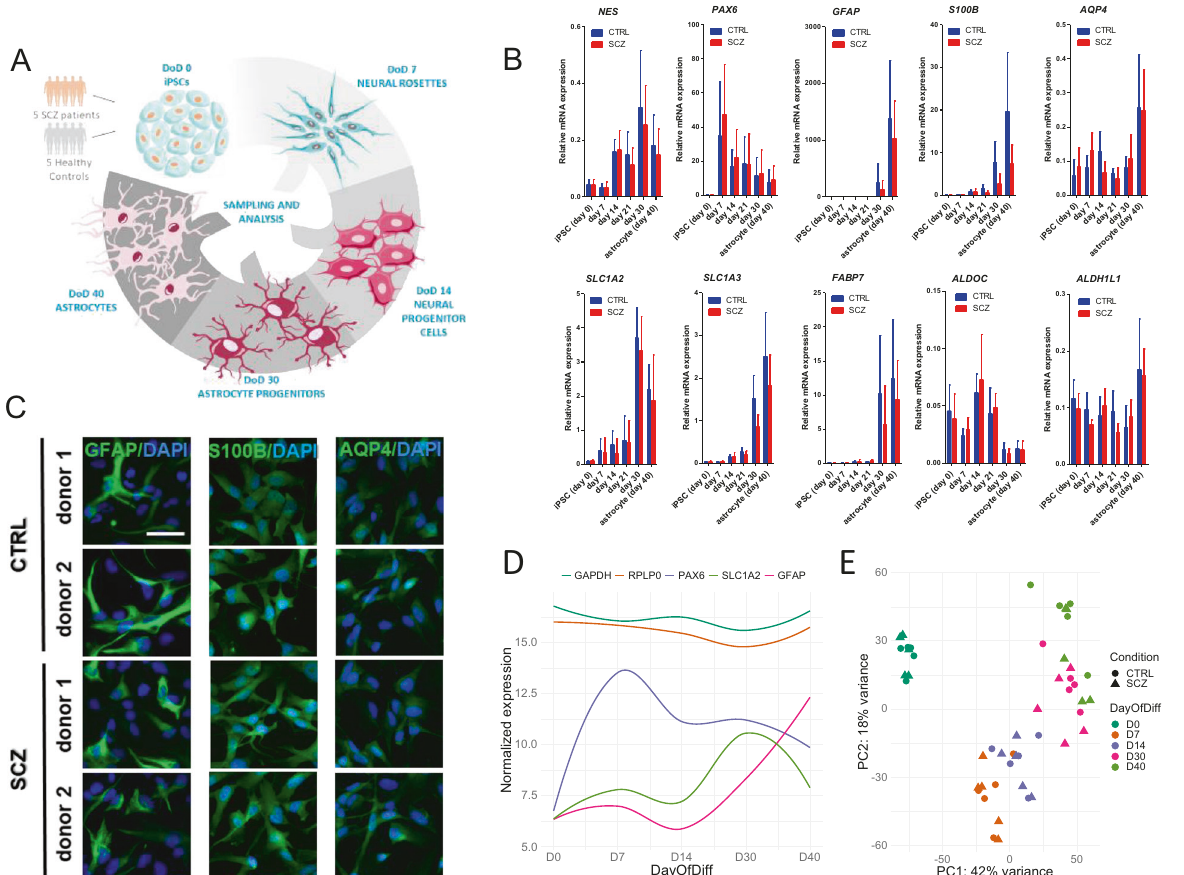
Fig. 1 Characterization of iPSC-derived astrocytes. A Diagram of the main stages of the study. DoD: day of differentiation. This fi gure was created using Servier Medical Art templates, which are licensed under a Creative Commons Attribution 3.0 Unported License; https://smart. servier.com. B Gene expression analysis by qPCR of NPC (PAX6, NES) and astrocyte-speci fi c markers (GFAP, S100B, SLC1A2, SLC1A3, FABP7, AQP4, ALDH1L1, ALDOC) in SCZ (red bars) and CTRL cultures (blue bars). Data of triplicate measurements of fi ve independent donors per group are presented as mean ± SEM. C Cells from day 40 cultures stained positive for the key astrocyte markers GFAP, S100B, and AQP4. Images of 2 representative CTRLs and 2 donors with SCZ out of 5 are presented. Scale bar: 200 μ m. D Normalized gene expression patterns of two housekeeping genes ( GAPDH and RPLP0 ) and speci fi c markers of astrocyte differentiation. Con fi dence interval: 0.5. E Principal component analysis (PCA) showing clustering of samples across the fi rst two principal components (PC) based on the top 1000 genes with most variance between (Fig. 5A – C). Of these, the two most signi fi cant DE genes were VWA5A (FDR = 1.6e − 8) and ADAMTS19 (FDR = 1.6e − 8), both of which were signi fi cantly downregulated in SCZ astrocytes relative to CTRLs at day 40 (Fig. 5B and D). Using external data sets, we found that the SCZ association of these two genes is speci fi cally related to astrocytes rather than other cell types or a speci fi c brain region (Suppl. Fig. 9). We further measured these genes at the protein level with ELISA, which con fi rmed signi fi cantly reduced levels of ADAMTS19 ( p = 0.0073) in SCZ astrocytes relative to CTRLs (Fig. 5E). In addition, while we did not detect protein level expression of VWA5A at baseline in our cell cultures, IL-1 β treatment of cells resulted in protein level expression of VWA5A in both CTRL and SCZ astrocytes. Interestingly, however, no signi fi cant differences were observed in the levels of VWA5A between IL-1 β treated CTRL and SCZ astrocytes (Suppl. Fig. 10). Fuzzy C-means clustering of the 786 unique SCZ-related genes revealed 5 distinct clusters (Fig. 5F; Suppl. Fig. 11; Suppl. Table 7). Annotation of these clusters showed that molecular functions related to ion channel activity (clusters 2 and 5) displayed a downward trend during differentiation in SCZ patients, while functions related to transcriptional regulation (cluster 1) and extracellular matrix structure (cluster 3) displayed an upward